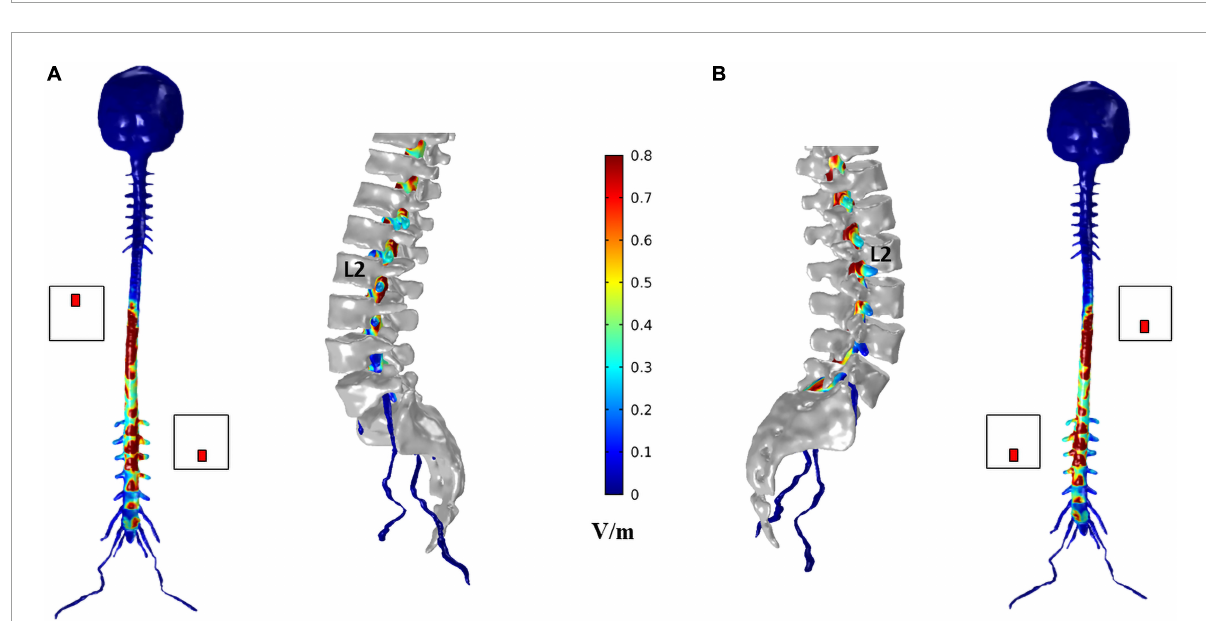
FIGURE6 Electric field (E-field) magnitude distribution in the spinal dura and roots for T8 left—L2 right montage (A) and T8 right—L2 left montage (B) . For each montage, a coronal view of the magnitude on the spinal dura is represented on the left and a sagittal view of spinal dura and vertebra near the L2 electrode position on the right. A color scale for the E-field magnitude is presented in the center.